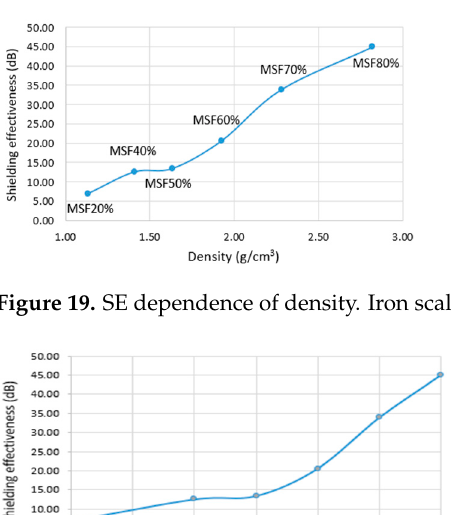
Figure 18. Waveguide and the horn antenna.